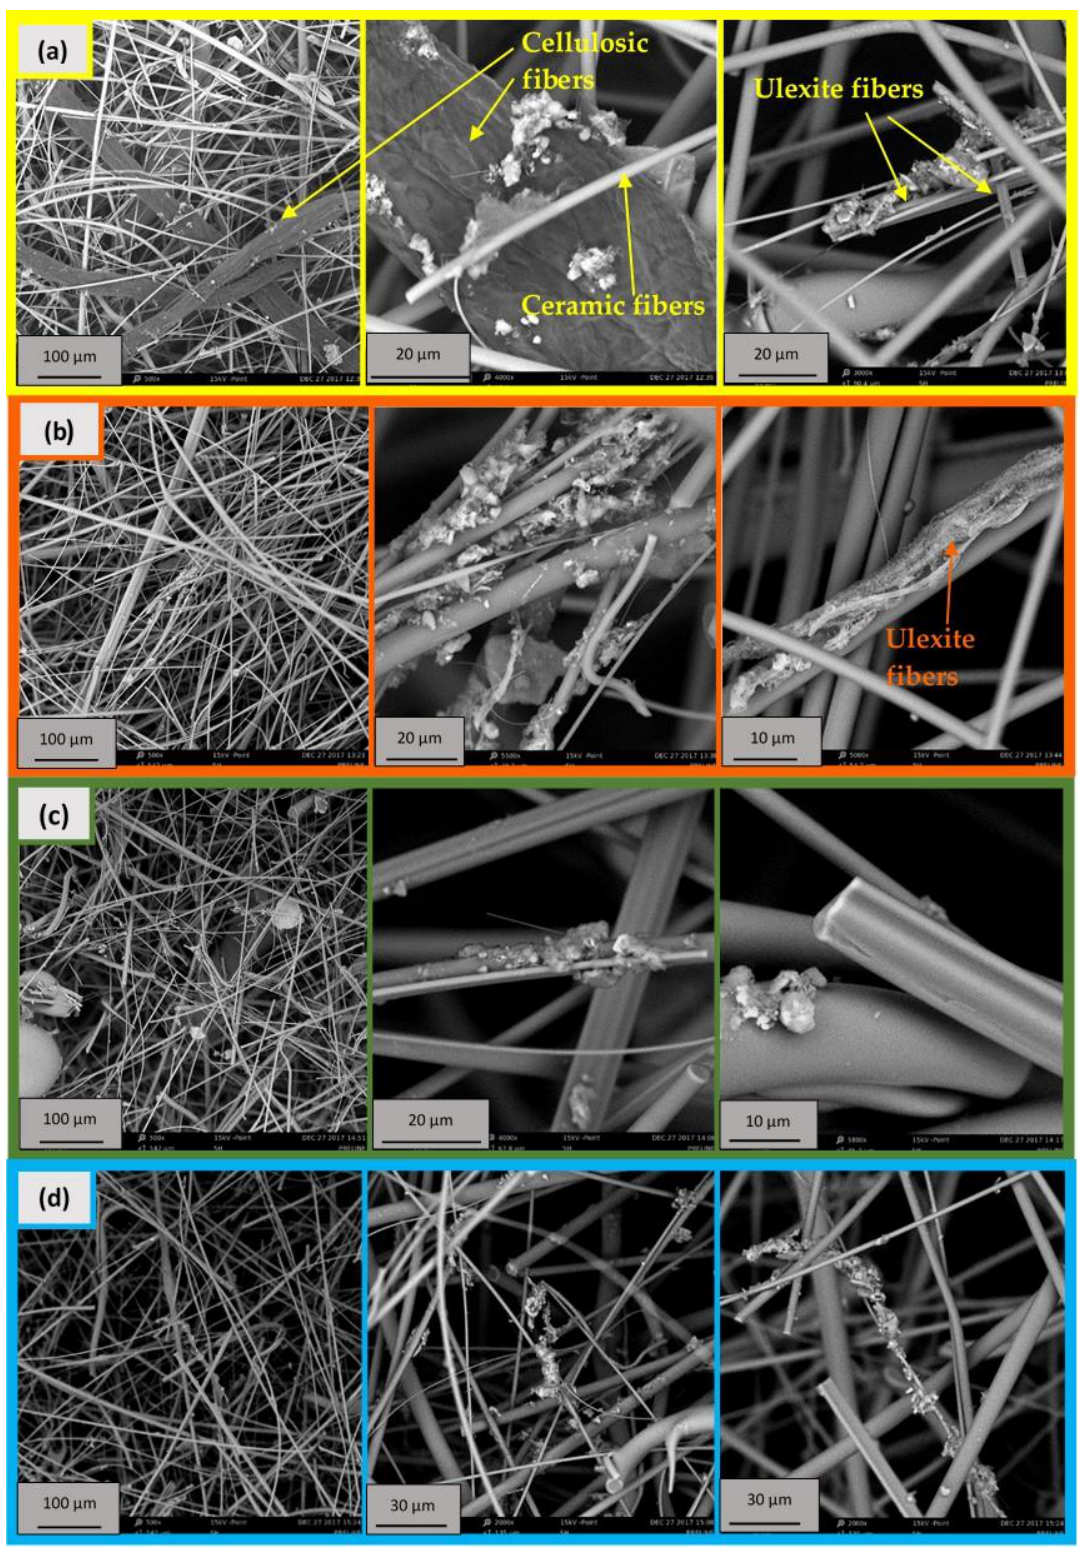
Figure 4. SEM micrographs of ceramic papers prepared with 3.2 g of ulexite, uncalcined and calcined at different temperatures: ( a ) U-3.2, ( b ) U-3.2-600, ( c ) U-3.2-650, and ( d ) U-3.2-700.